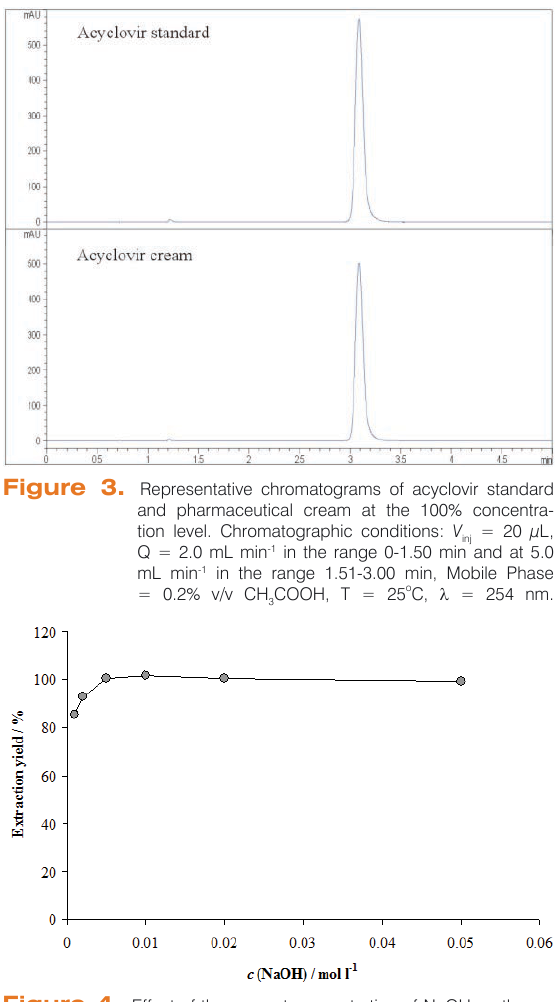
Figure 4. Effect of the amount concentration of NaOH on the ex - traction of